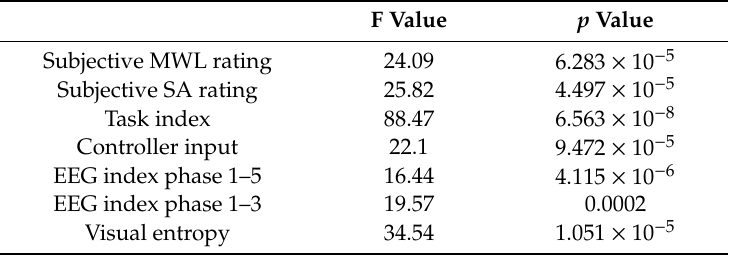
Table 3. All results from the ANOVA analysis.